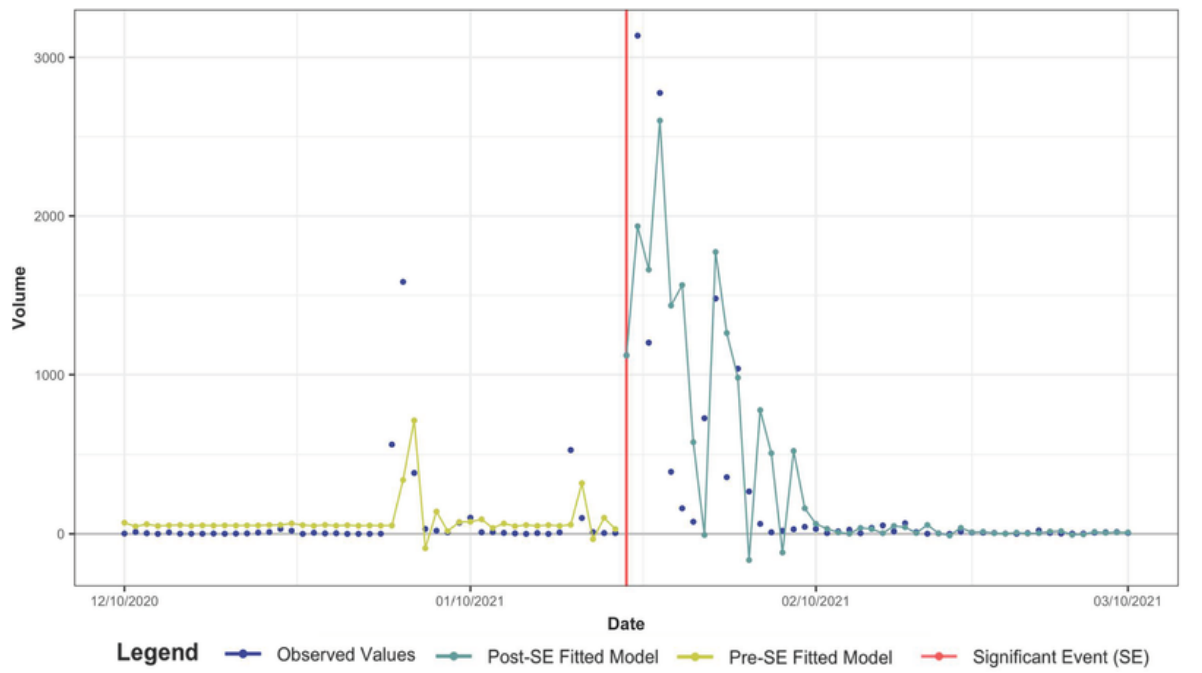
Figure 4. Plot of ARIMA Models before and after Maduro’s “miracle cure” announcement. ARIMA = autoregressive integrated moving average. From COVID